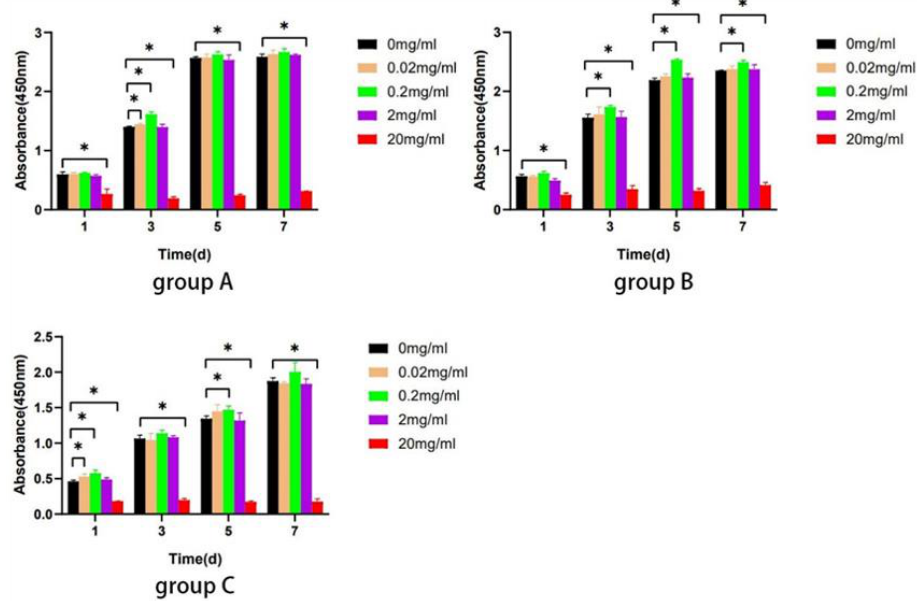
Figure 7. Biodentine on the proliferation ability of hDPSCs. The CCK-8 assay was performed after stimulation with different concentrations of Biodentine on days 1, 3, 5, and 7. * p < 0.05, versus con- trol.